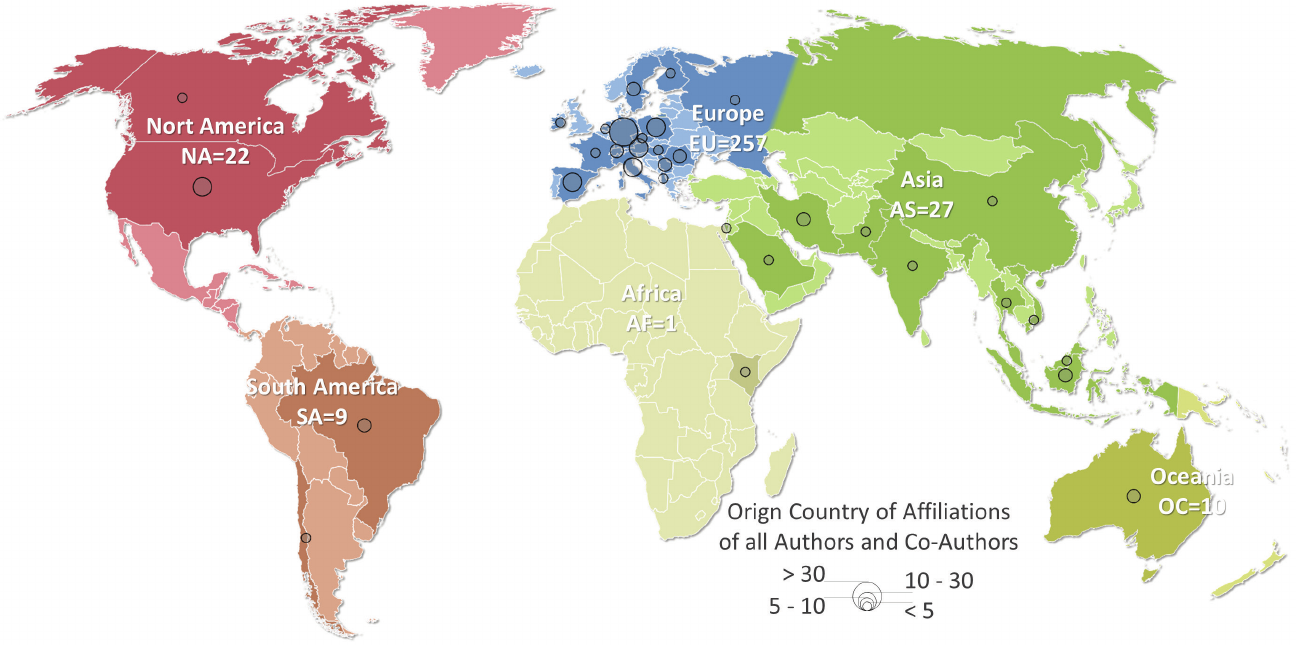
Figure 1. Spatial distribution of authorship based on affiliations contributing to publications in Landscape Online from 2007-2022 (n=326).